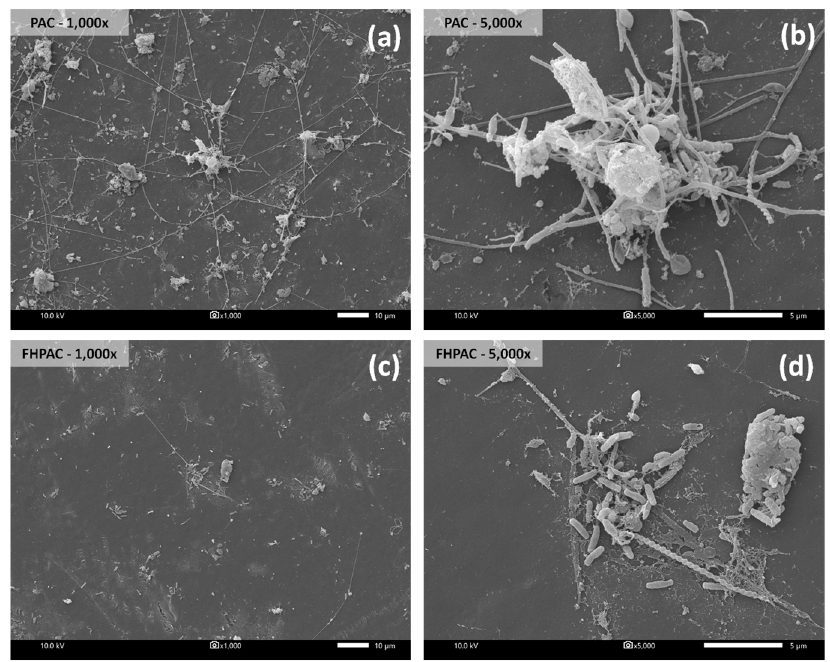
Figure 7. SEM images of PAN membrane after operation with PAC ( a , b ) and FHPAC ( c , d ) adsorption under magnifications of 1000× and 5000×, respectively.